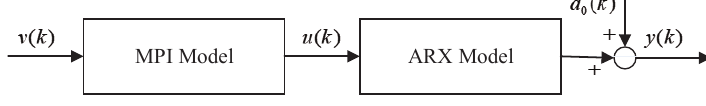
Figure 2. Hammerstein model for DEAP